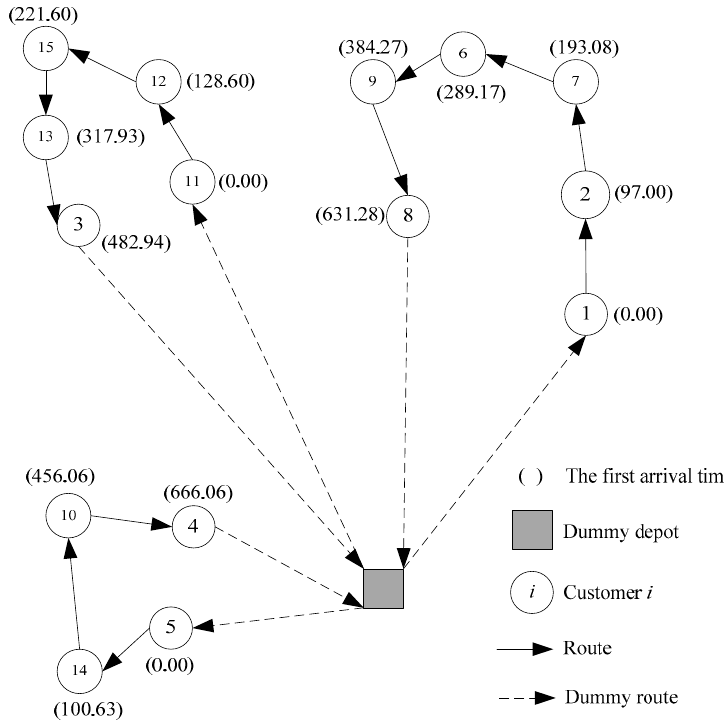
Figure 3. Visual illustration of the example solution given in Figure 2.